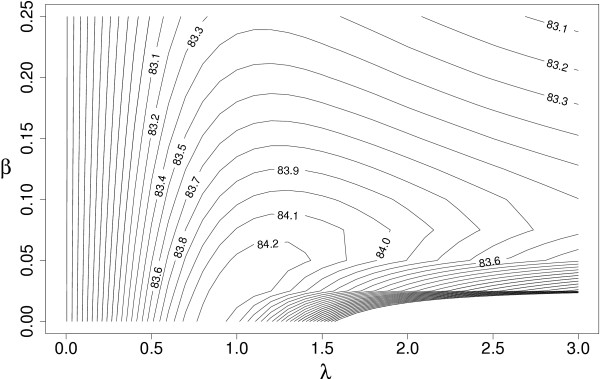
Parameter estimation: The performance of WAC with s = 55 as a function of the weighting parameters λ and β. The best performance is reached at λ = 1.0 and β = 0.025.